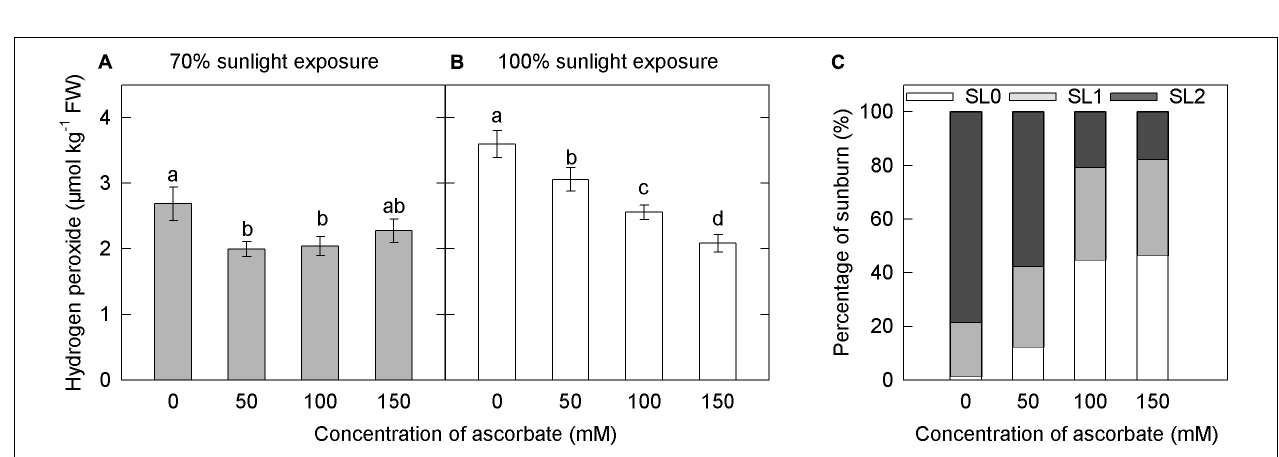
FIGURE 9 | Effects of exogenous ascorbate on the concentration of hydrogen peroxide and the percentage of sunburn under natural light conditions in the peel of “Fuji” apple fruits. Concentration of hydrogen peroxide in the peel of “Fuji” apple fruits soaked in ascorbate of 0, 50, 100, and 150 mM and 70% sunlight intensity (A) and 100% sunlight intensity (B) . The percentage of sunburn in the peel of “Fuji” apple fruits soaked in ascorbic acid of 0, 50, 100, and 150 mM under natural light conditions (C) .